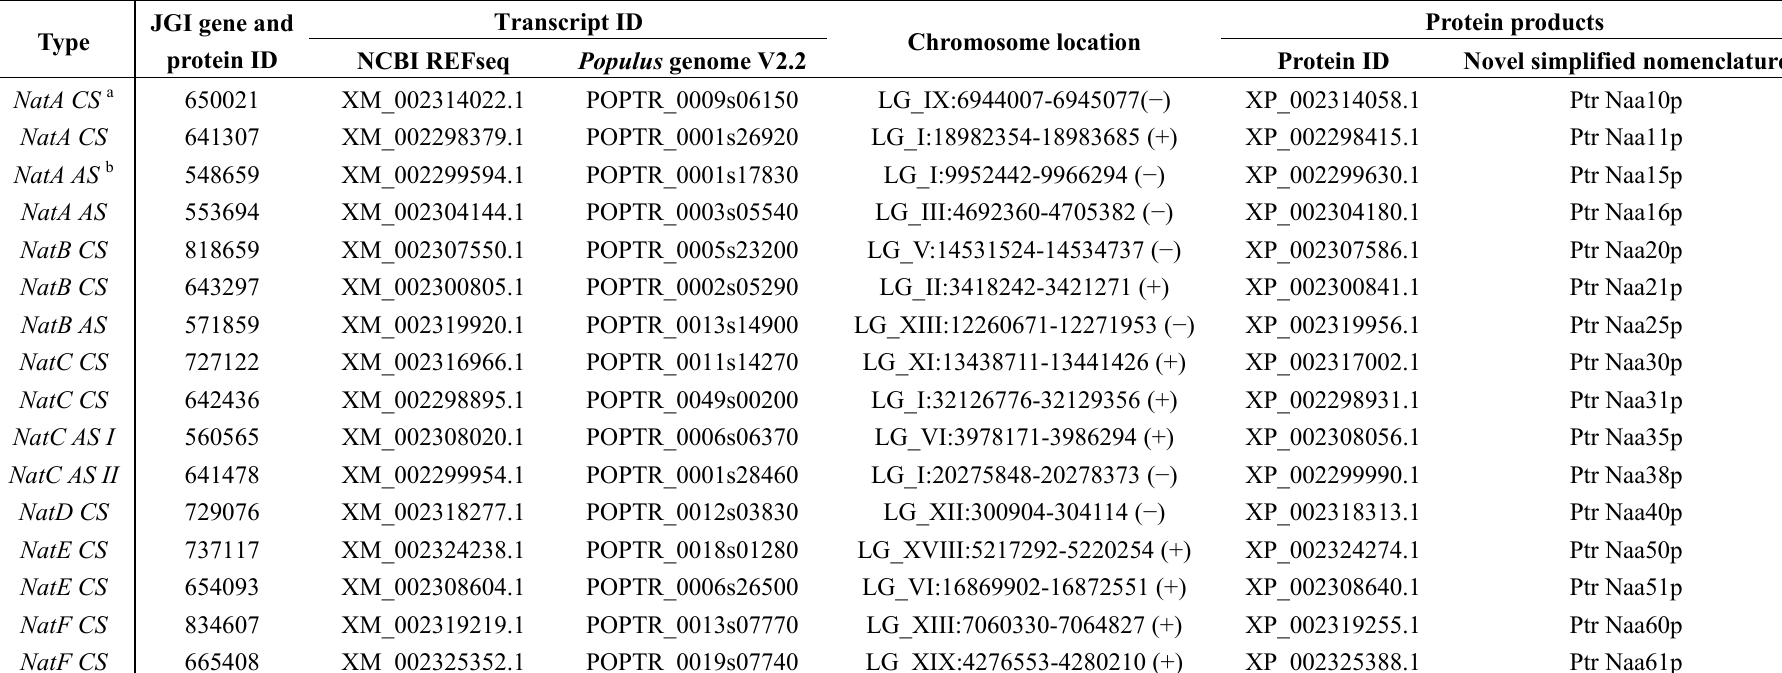
Table 1. All identified N -terminal acetyltransferase (Nat) genes ( CS and AS ) and putative encoded poplypeptides present in Populus trichocarpa